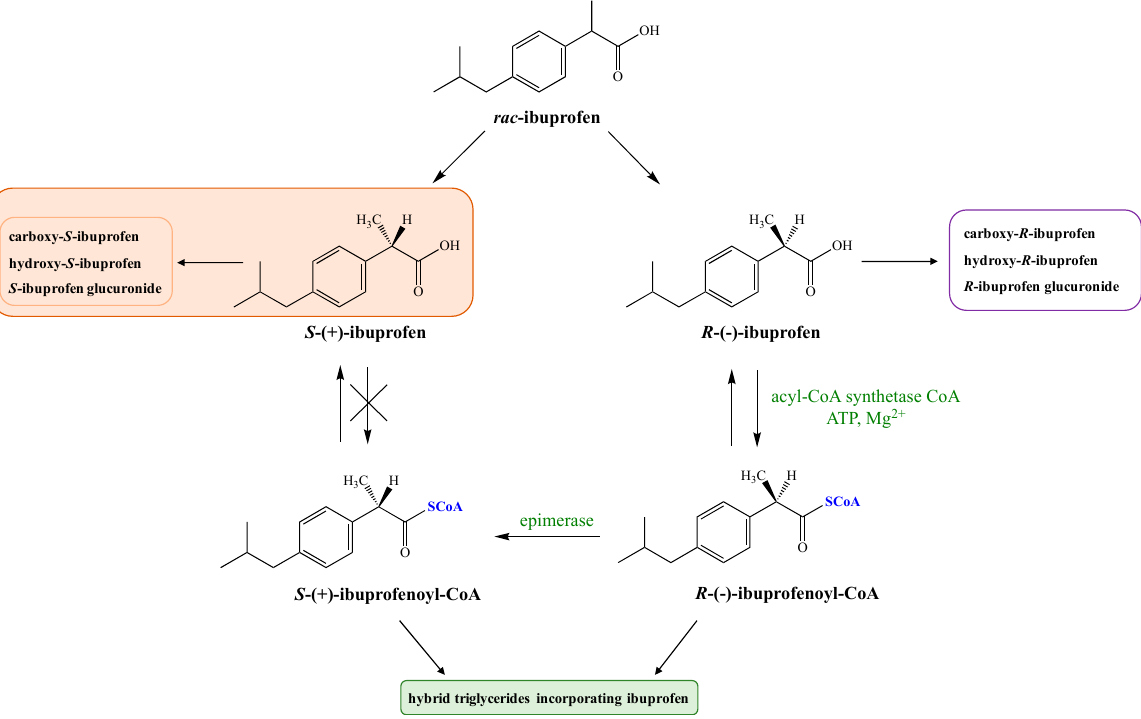
hybrid triglycerides incorporating Figure 1. Metabolic conversion of R -( − )-ibuprofen to S -(+)-ibuprofen. Figure 1. Metabolic conversion of R -( − )-ibuprofen to S -(+)-ibuprofen. Next, the AMP-derivative is esterified with coenzyme A (CoA) by the action of acyl-CoA synthetase. R -( − )-ibuprofen-CoA undergoes epimerization via the actions of